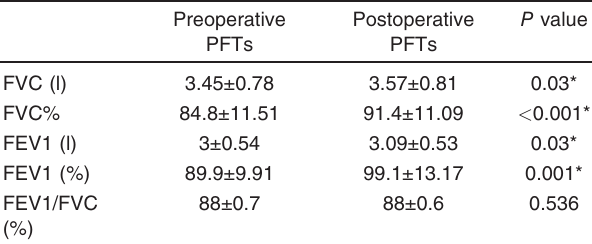
Table 4 Comparison between preoperative and postoperative pulmonary function tests among patients undergoing endoscopic sinus surgery